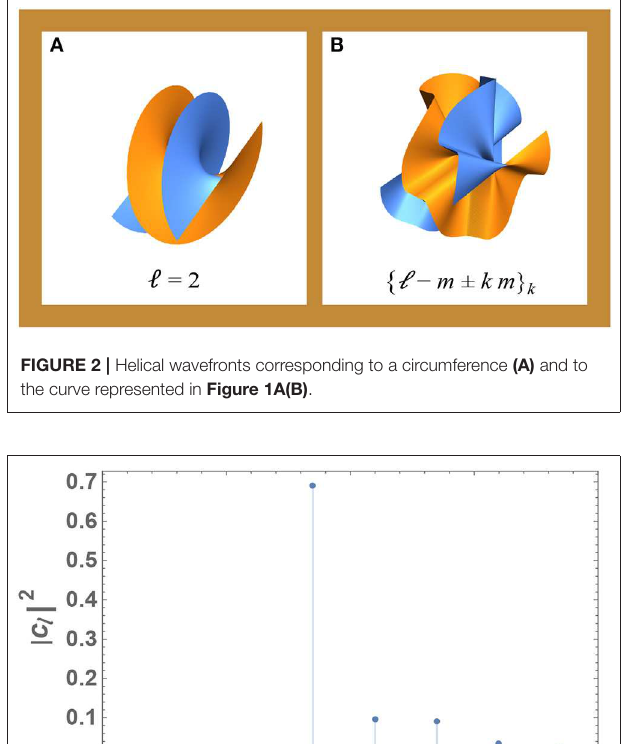
b 1, m 5, n 1 1 / 2, and = = = =